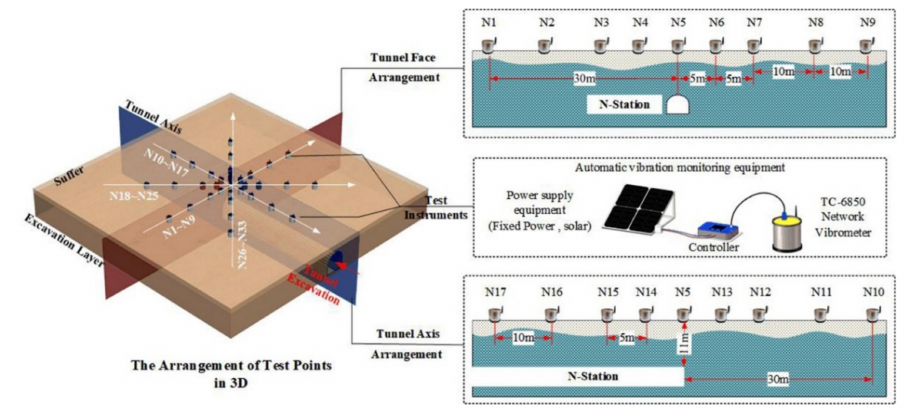
Figure 10. The arrangement of test points in